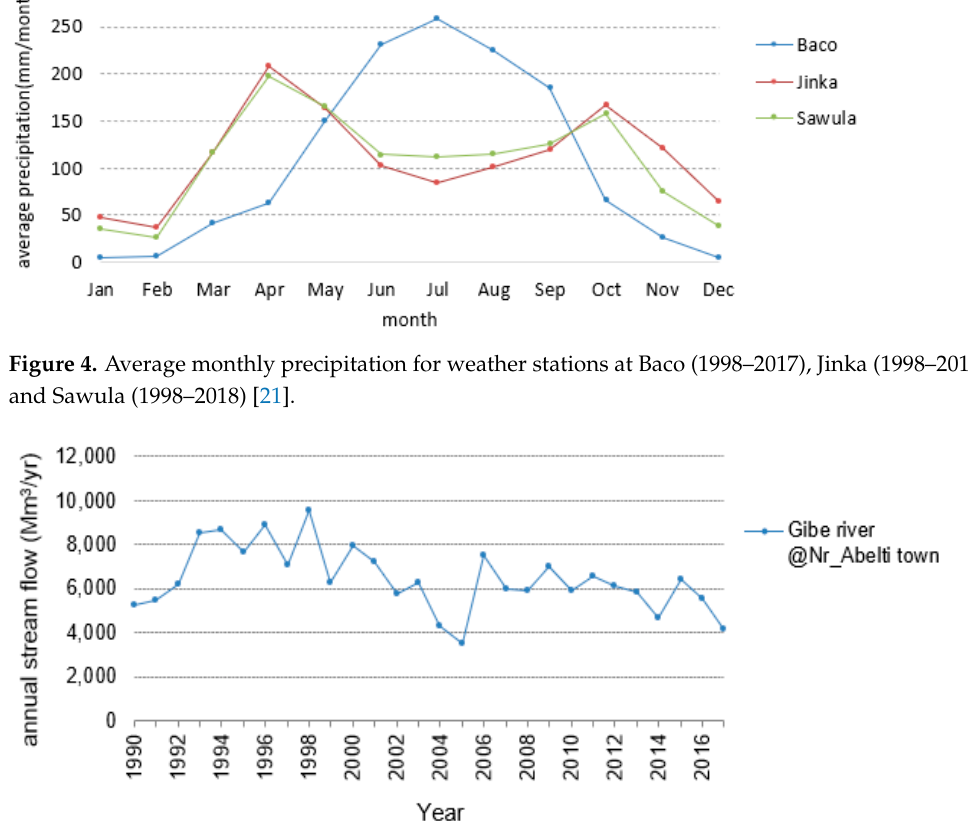
Figure 5. Annual stream flow of Gibe river at the gauge station near the Abelti town (1990–2016) [22].